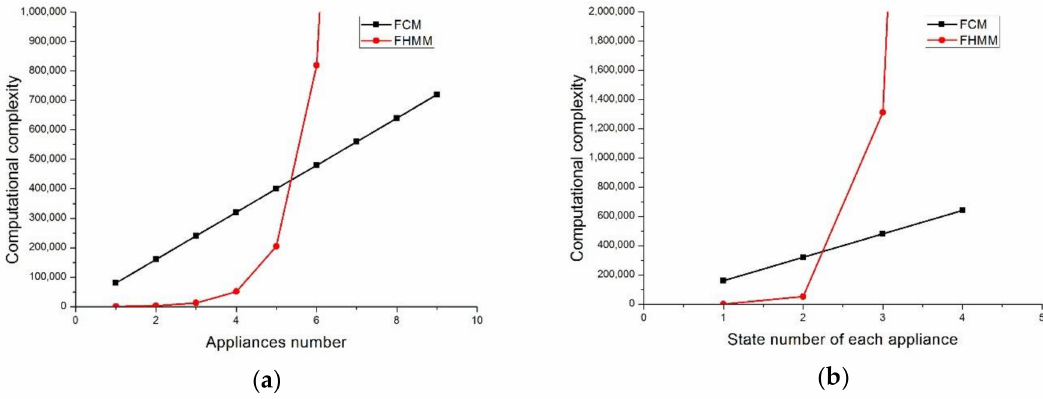
Figure 6. This is analysis of algorithm time complexity. There are two panels, they are listed as: ( a ) where M = 2, T = 200; and, ( b ) N = 4, T =